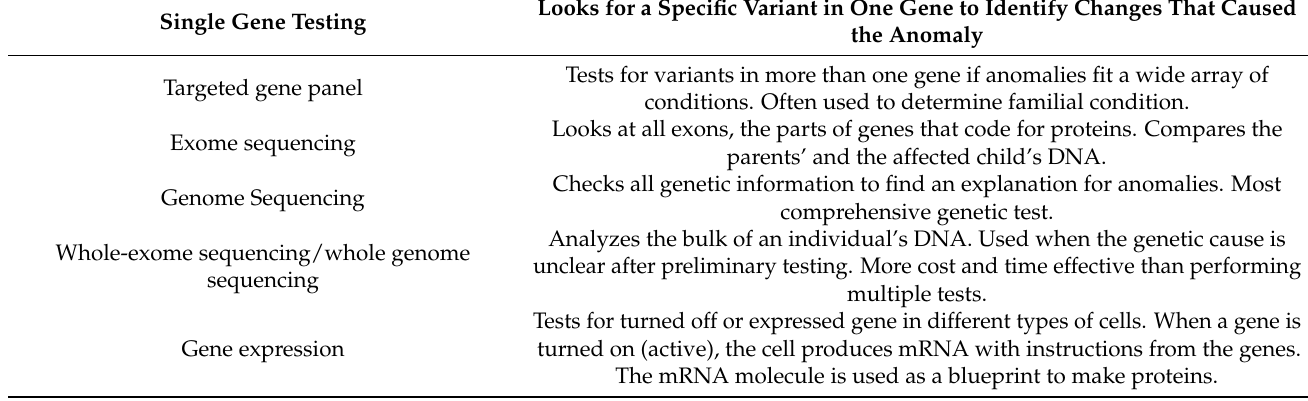
Table 1. Common genetic tests for congenital